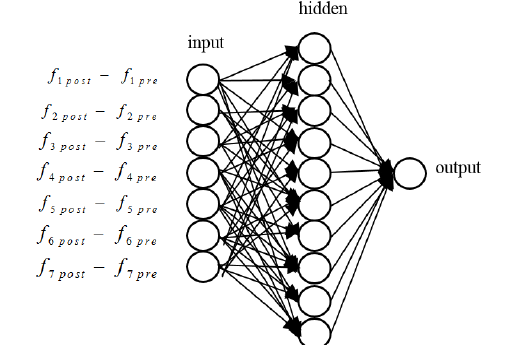
Figure 2. The structure of the proposed MLP network for buildings change